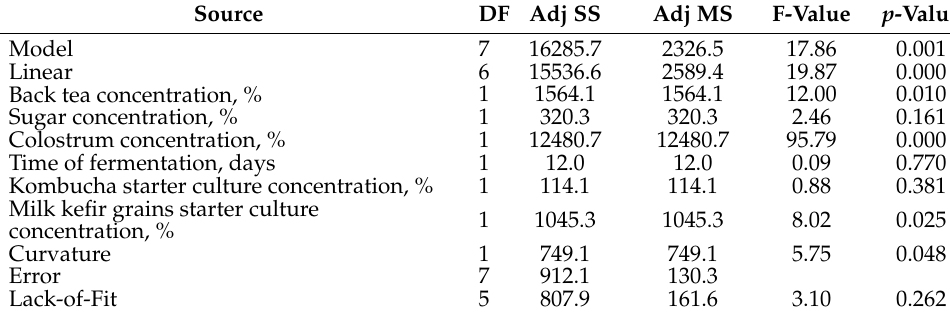
Table 4. ANOVA analysis of variance for the TA .